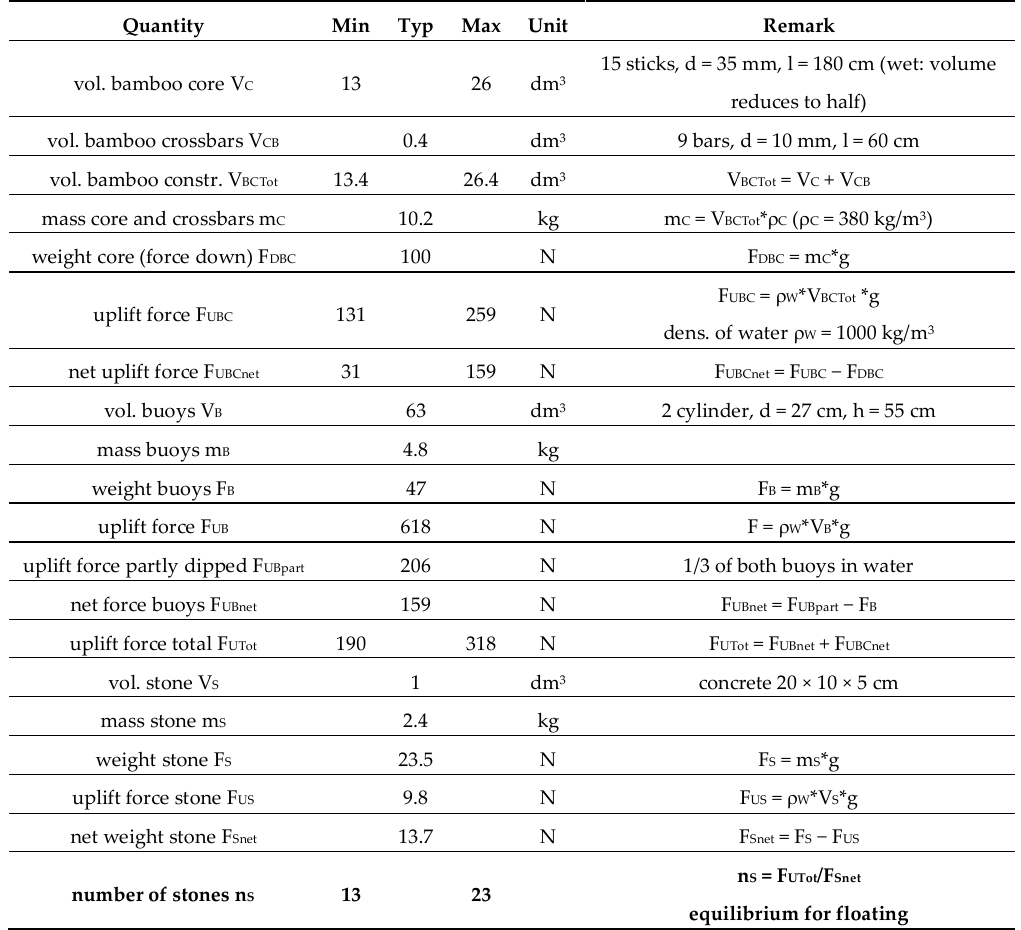
Table 2. Calculation of weight and uplift forces of the bamboo core and the additional weights (stones) to enable a stable floating in a certain depth for a span size of 9